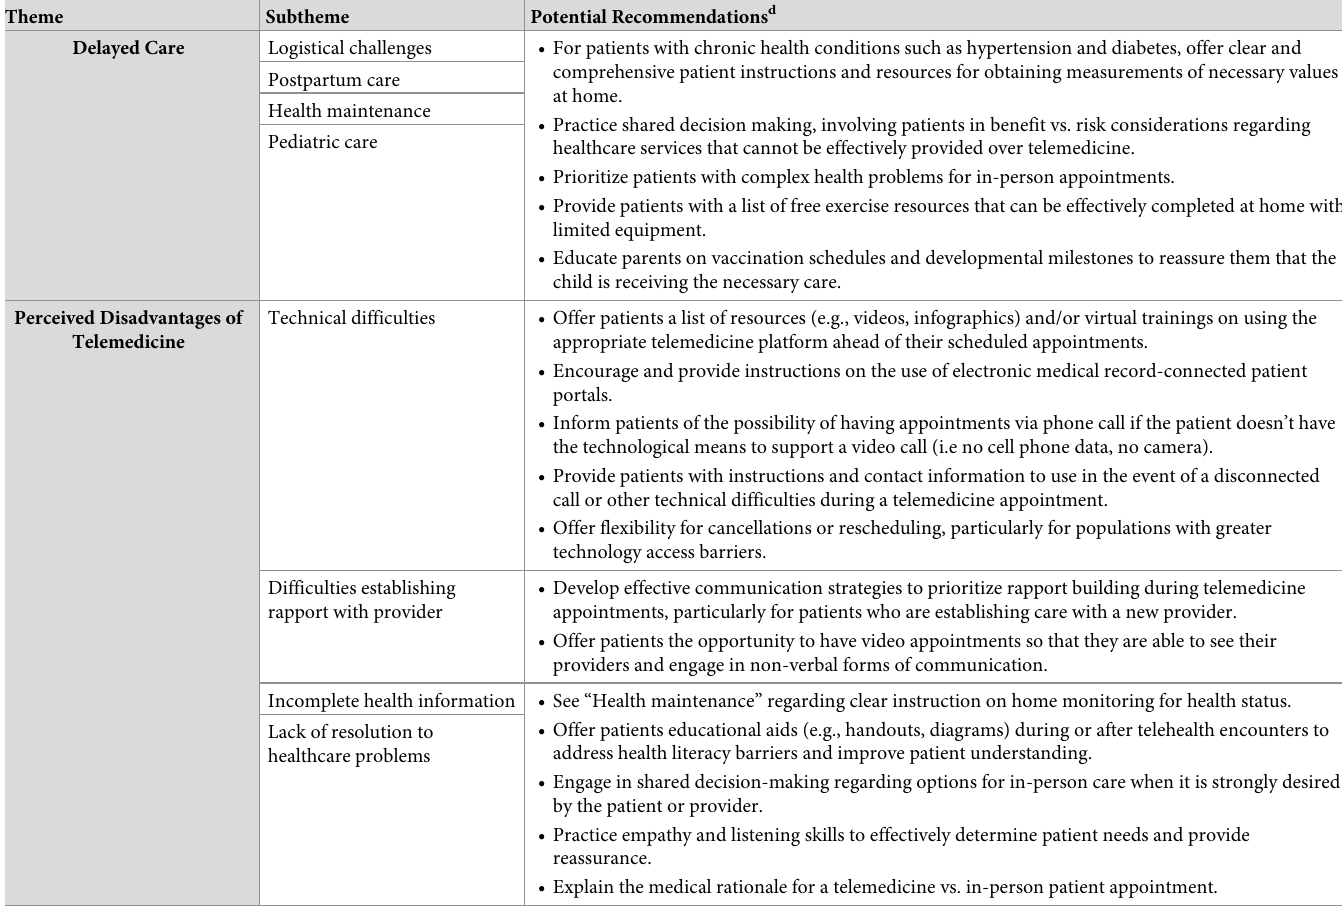
Table 6. Potential solutions generated from patient-reported challenges to healthcare access during the COVID-19 pandemic.